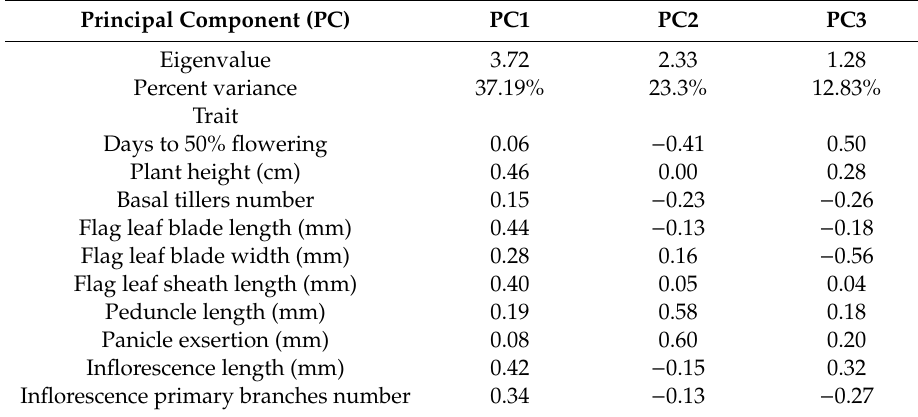
Figure 2. Neighbor-joining clustering of proso millet accessions based on morpho-agronomic traits. Color code: pink—Europe; green—Asia; blue—the Americas. Table 7. Principal component analysis of proso millet germplasm conserved at the ICRISAT genebank, India.